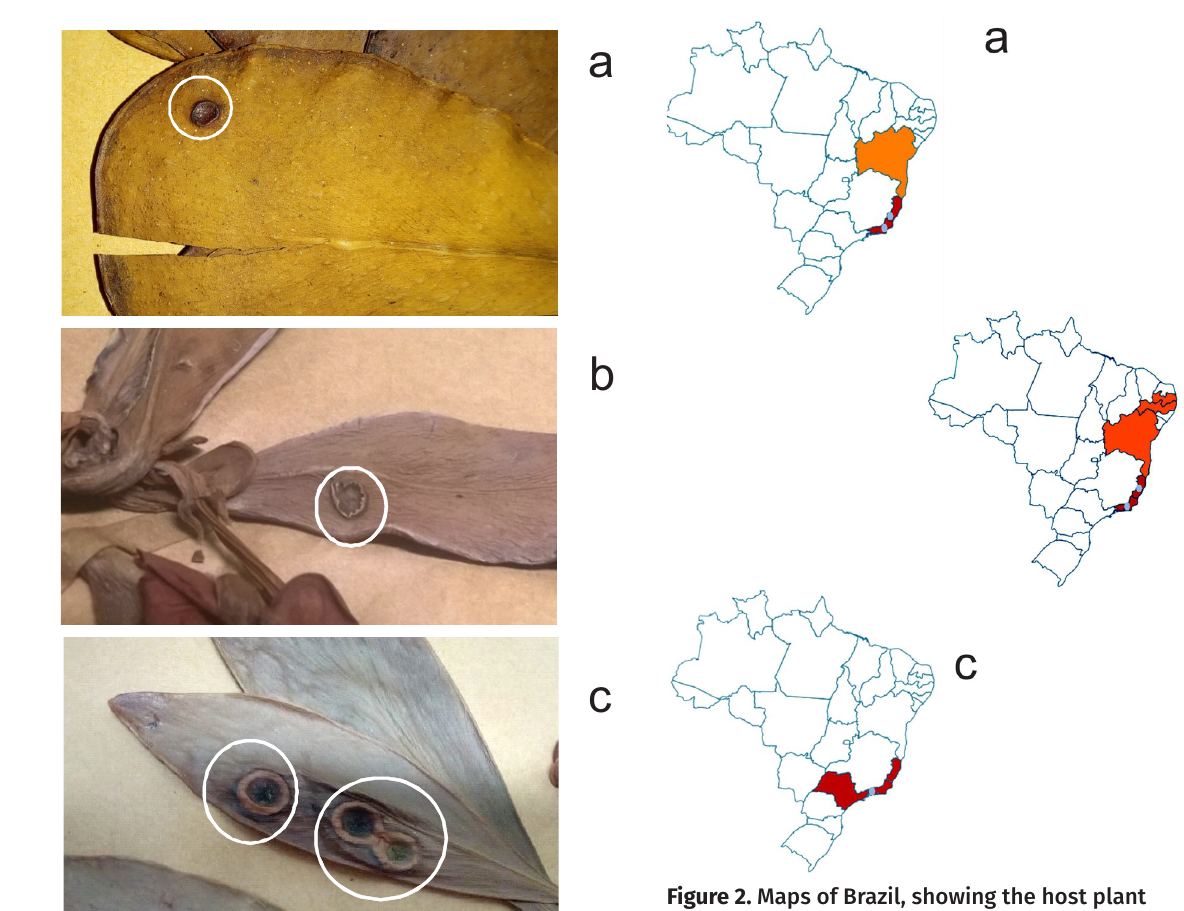
Figure 2. Maps of Brazil, showing the host plant distribution (colored area) and that of the gall- inducing species (Diptera, Cecidomyiidae) (colored circles). a. Clusia fluminense and Parazalepidota clusiae , b. Clusia hilariana and Clusiamyia granulosa , c. Clusia lanceolata and Clusiamyia